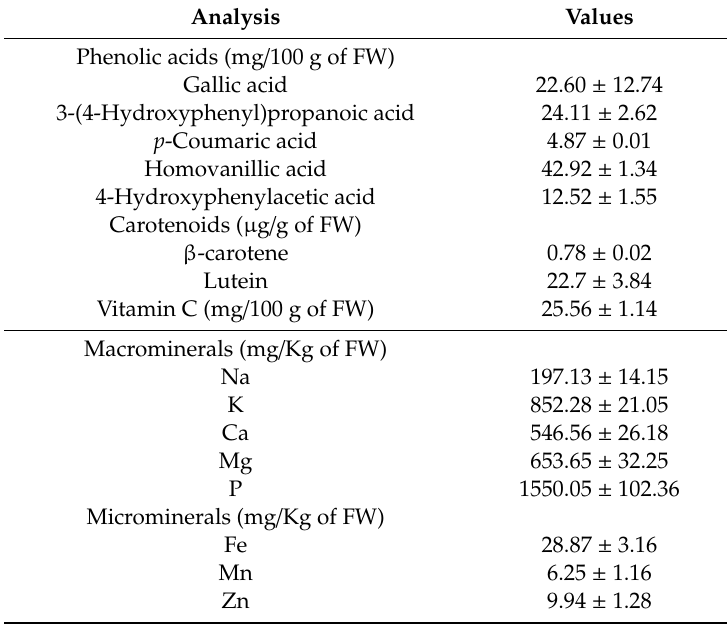
Table 1. Phenolic acids profile, carotenoids, vitamin C and mineral nutrients content of pechiche fruits.